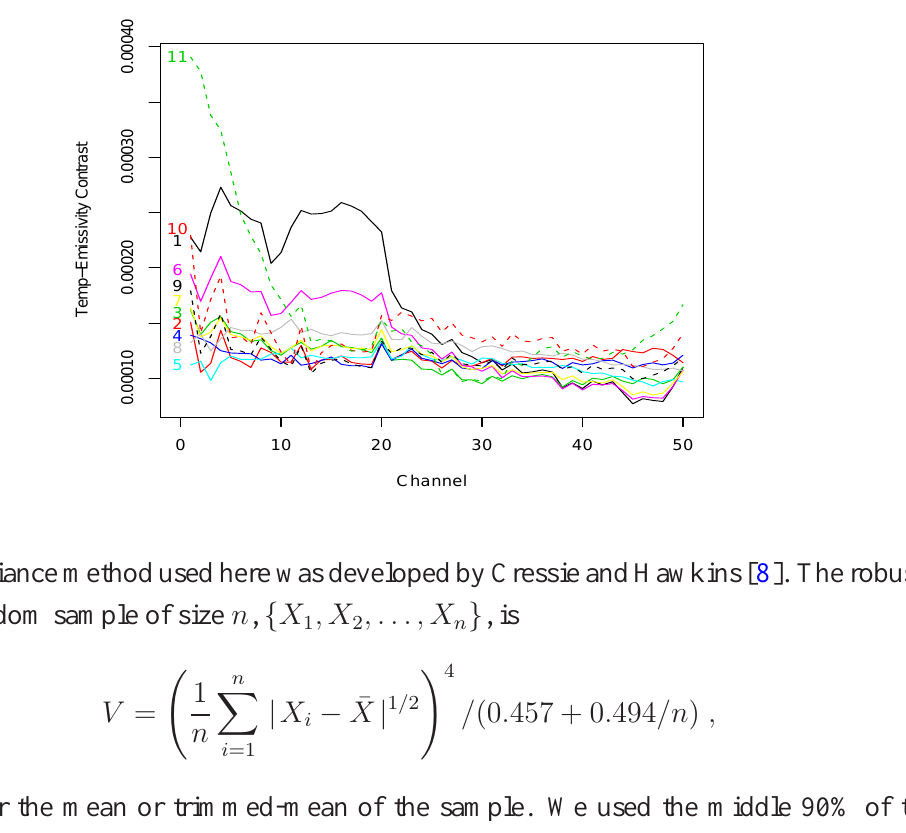
Figure 2. Endmember Temperature-Emissivity Contrasts. A plume temperature 5 ◦ K hotter than the average ground temperature of each pixel group was used to compute the temperature-emissivity contrasts for the